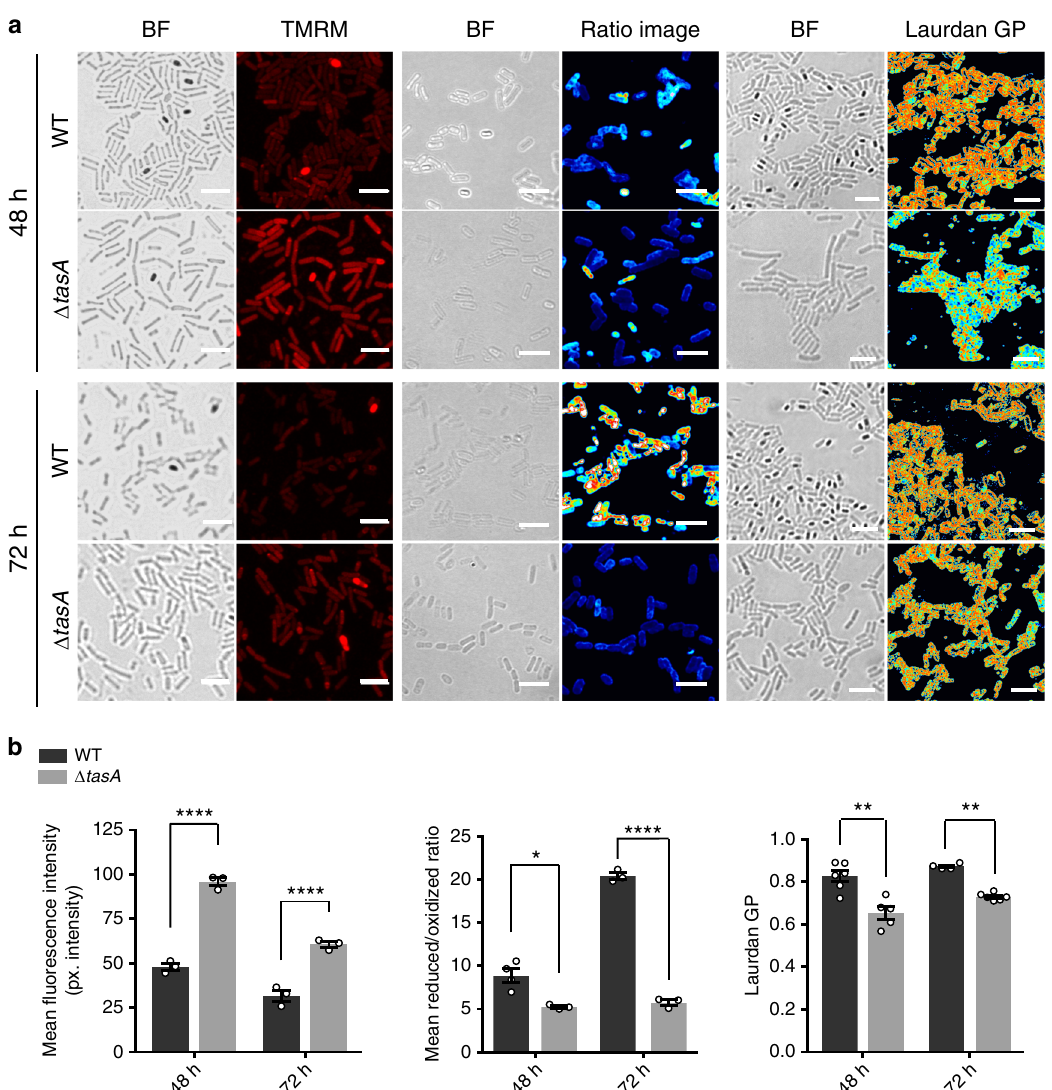
Fig. 6 Δ tasA cell membrane exhibit cytological anomalies. a Left panel. A TMRM assay of WT and Δ tasA cells, located at the top or bottom respectively in each set, showed a decrease in membrane potential in the WT cells, whereas the Δ tasA cells exhibited hyperpolarization at 48 and 72h. Center panel. Assessment of the lipid peroxidation levels using BODIPY 581/591 C11 reagent in WT and Δ tasA cells after treatment with 5 mM CuHpx and analysis by CLSM. The ratio images represent the ratio between the two states of the lipid peroxidation sensor: reduced channel (590 – 613nm emission) /oxidized channel (509 – 561nm emission) . The ratio images were pseudo-colored depending on the reduced/oxidized ratio values. A calibration bar (from 0 to 50) is located at the bottom of the panel. Confocal microscopy images show that CuHpx treatment was ineffective in the WT strain at 72 h, whereas the mutant strain showed symptoms of lipid peroxidation. Right panel. Laurdan GP analyzed via fl uorescence microscopy. The images were taken at two different emission wavelengths (gel phase, 432 – 482 nm and liquid phase, 509 – 547 nm) that correspond to the two possible states of the Laurdan reagent depending on the lipid environment. The Laurdan GP images represent the Laurdan GP value of each pixel (see Methods section). The Laurdan GP images were pseudo- colored depending on the laurdan GP values. A calibration bar (from 0 to 1) is located at the bottom of the set. The Laurdan GP images show an increase in membrane fl uidity (lower Laurdan GP values) in the tasA mutant cells at 48 and 72h. All scale bars are equal to 5 µ m. b Left. Quanti fi cation of the TMRM signal. N = 3. Center. Quanti fi cation of lipid peroxidation. N = 3. For the WT at 48h, N = 4. Right. Quanti fi cation of laurdan GP values. For the WT strain, N = 6 at 48h and N = 4 at 72h. For the Δ tasA strain, N = 5 at all times. N refers to the number of colonies examined over three independent experiments. Average values are shown. Error bars represent the SEM. For each experiment and sample, at least three fi elds-of-view were measured. Statistical signi fi cance in the TMRM experiments was assessed via two-tailed independent t -tests at each time-point (**** p < 0.0001). Statistical signi fi cance in the lipid peroxidation experiments was assessed via two-tailed independent t -tests at each time-point (**** p < 0.0001, * p value = 0.0115). Statistical signi fi cance in the laurdan GP experiments was assessed via two-tailed independent Mann – Whitney tests at each time-point (** p value = 0.0087 at 48h and ** p value = 0.0095 at 72h respectively). Source data are provided as a Source Data fi